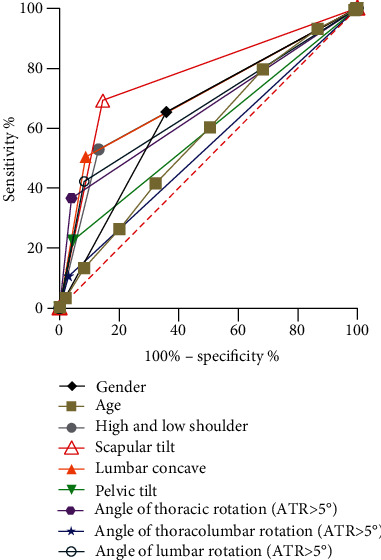
Results of ROC curve analysis by different risk factors. Gender: AUC = 0.65, 95% CI: 0.62-0.68, P < 0.001; age: AUC = 0.57, 95% CI: 0.54-0.61, P < 0.001. Shoulder-height difference: AUC = 0.70, 95% CI: 0.67-0.73, P < 0.001; scapular tilt: AUC = 0.77, 95% CI: 0.75-0.80, P < 0.001; lumbar concave: AUC = 0.71, 95% CI: 0.68-0.74, P < 0.001; pelvic tilt: AUC = 0.59, 95% CI: 0.56-0.62, P < 0.001; angle of thoracic rotation (ATR>5°): AUC = 0.66, 95% CI: 0.63-0.69, P < 0.001; angle of thoracolumbar rotation (ATR>5°): AUC = 0.54, 95% CI: 0.51-0.57, P = 0.023; angle of lumbar rotation (ATR>5°): AUC = 0.67, 95% CI: 0.64-0.70, P < 0.001. ROC curve results for flat back, thoracic kyphosis, and lumbar kyphosis were not shown because there was no statistical difference in its AUC value.